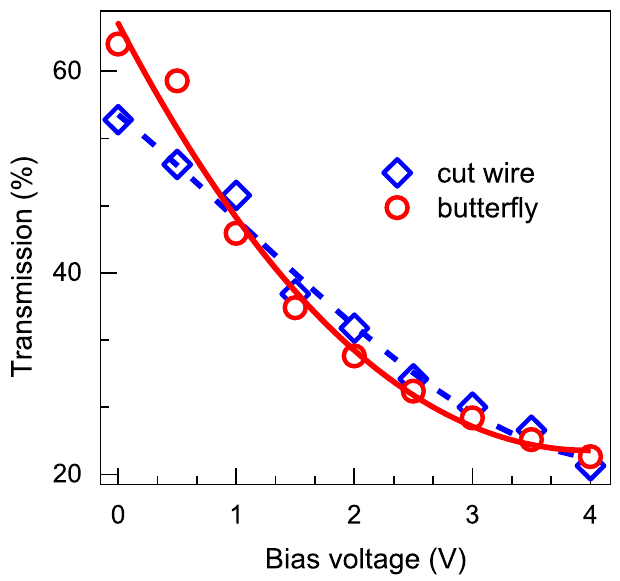
Fig. 5. The transmission at the on-resonance frequency with different bias voltages ranging from 0 to 4V for the two hybrid